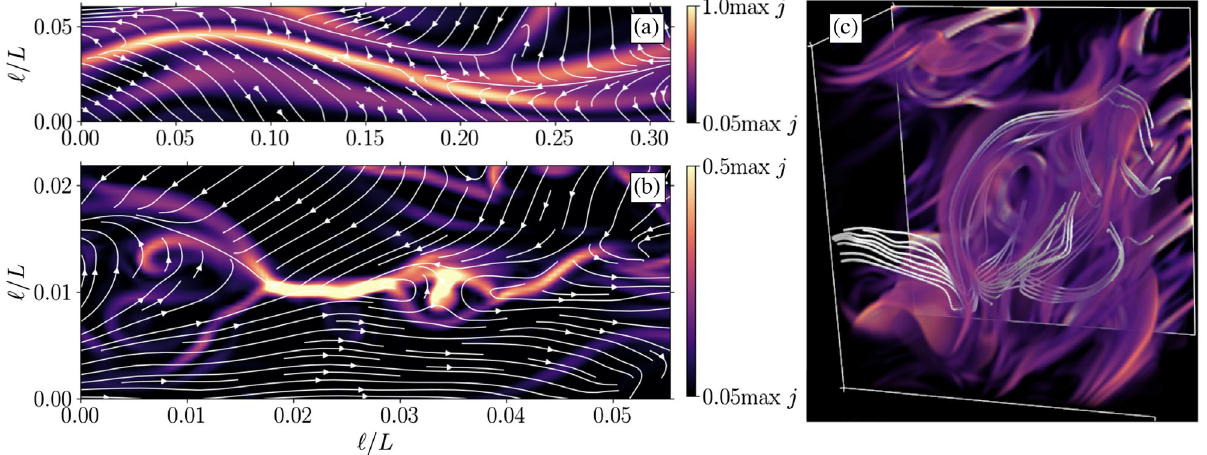
FIG. 4. Example of a typical current sheet during saturation for Pm ¼ 10 at resolution 560 3 (a) and 2240 3 (b) (runs b2 and d2, respectively). Color shows the magnitude of the current density; magnetic-field lines are traced by white arrows. Panel (c) shows a 3D rendering of the current density (color) in a typical plasmoid formed within a disrupted current sheet that is oriented diagonally from bottom left to top right. Magnetic-field lines (white) originate in a small area below and wrap around the central plasmoid; a slice of the current density is also displayed on the back face of the